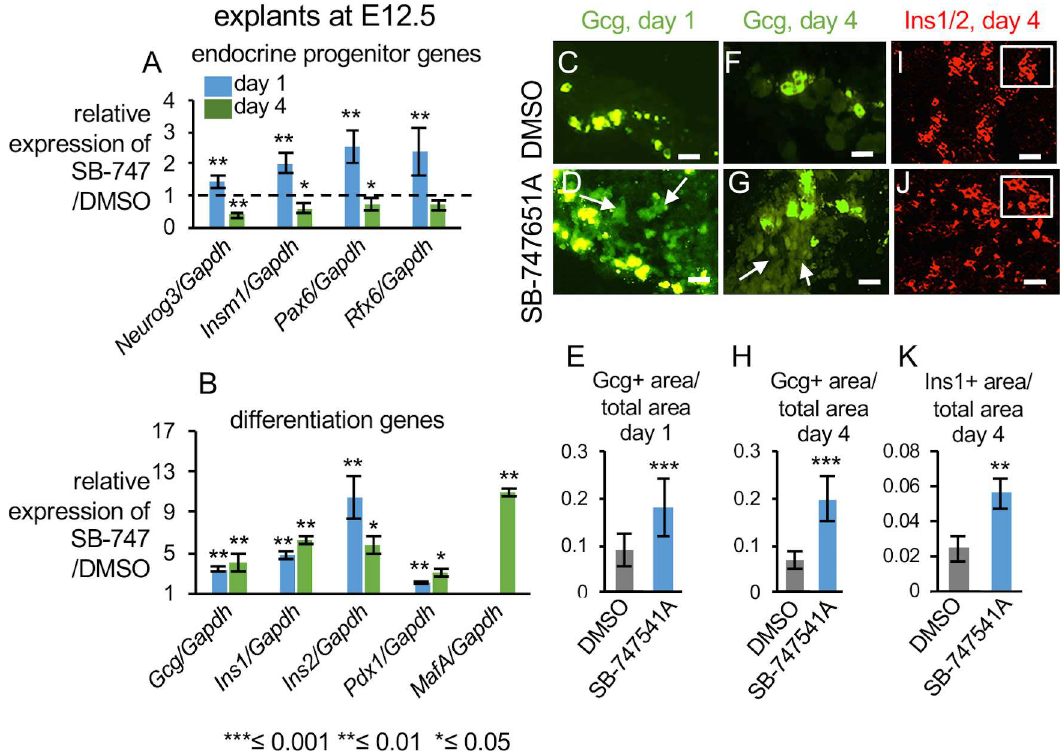
Fig 4. SB-747651Atreatment causesincreased differentiation of E12.5 pancreatic progenitors towards the endocrine lineage. (A) RT-qPCR analysisof indicatedendocrineprogenitorgeneson day 1 (blue) and day 4 (green)of SB-747651A treatment in pancreatic explantsfrom E12.5. Y-axis shows normalized enrichmentin SB-747651A treated relative to DMSO controls. The P-valuesfor day1 are (cid:20) 0.01 for all genes examined,for day4 are 0.008, 0.02, 0.04, 0.1 respectivelyfor Neurog3 , Insm1 , Pax6 , and Rfx6 . n (cid:21) 10 pancreatawere pooledfor each RT-qPCR experiment for DMSO and SB-747651A treatment and for eachbiologicalreplicate,n = 2 biologicaland n = 3 technicalreplicatesfor each. (B) RT-qPCRanalysisof indicatedendocrinedifferentiation geneson day 1 (blue)and day 4 (green) of SB-747651Atreatment in pancreaticexplantsfrom E12.5. Y-axis shows normalizedenrichmentin SB-747651A treated explantsrelativeto DMSO controls. The P-valuesfor day1are (cid:20) 0.01 and for day4are 0.01, 0.002, 0.05, 0.03 for Gcg , Ins1 , Ins2 , and Pdx1 respectively. n (cid:21) 10pancreata werepooledfor each RT-qPCR experimentfor DMSO and SB-747651Atreatment and for each biologicalreplicate,n = 2 biologicaland n = 3 technical replicatesfor each. (C-H) Immunohistochemistry and quantification of Glucagonpositivedomainin pancreaticsections upononeday (C-E, P-value= 0.001)and 4 days of SB- 747651Atreatment (F-H, P-value (cid:20) 0.0001), n (cid:21) 5pancreatawere analyzedfor immunohistochemistry for each biological replicateandfor each condition,DMSO andSB-747651Atreatment. n = 2 biologicalreplicatesScale bar = 50 μ m.The panelsC and D were exposed to reveal cellsexpressinglower levels of Gcg. (I-K) Immunohistochemistry and quantification of Insulin1/2 positivedomainin pancreaticsectionsuponSB-747651Atreatment on day4 at E12.5 stage, P-value,0.005, n (cid:21) 5pancreatafor each biologicalreplicate and for eachcondition,DMSO and SB-747651A treatment. n = 2 biological replicates, scalebar = 25 μ m.Insets on panelsI and J shows magnifiedviews to highlightcytoplasmicstainingof Ins1/2. All area measurements were donerelativeto the total pancreaticarea per section. Arrows in D, G show low level expression of Glucagonin explantstreated with SB-747651A treatment. Valuesare averagesof 3 independentexperiments ± standard error unlessotherwisestated. All P-valueswere calculated by Student’st test, comparing DMSO and SB-747651A treated samplesin independent experiments, * (cid:20) 0.05, ** (cid:20) 0.01, *** (cid:20)